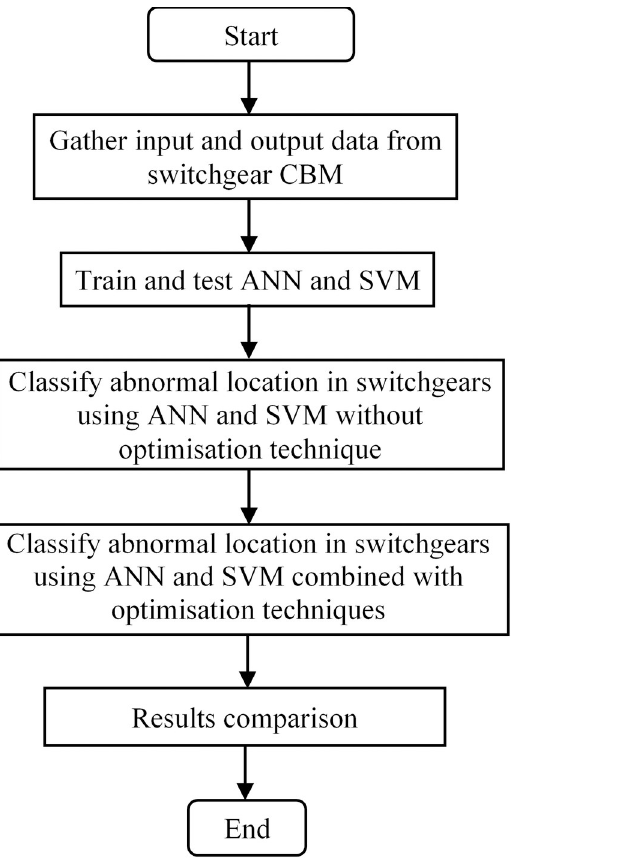
Fig 1. Flowchart of the overall methodology.